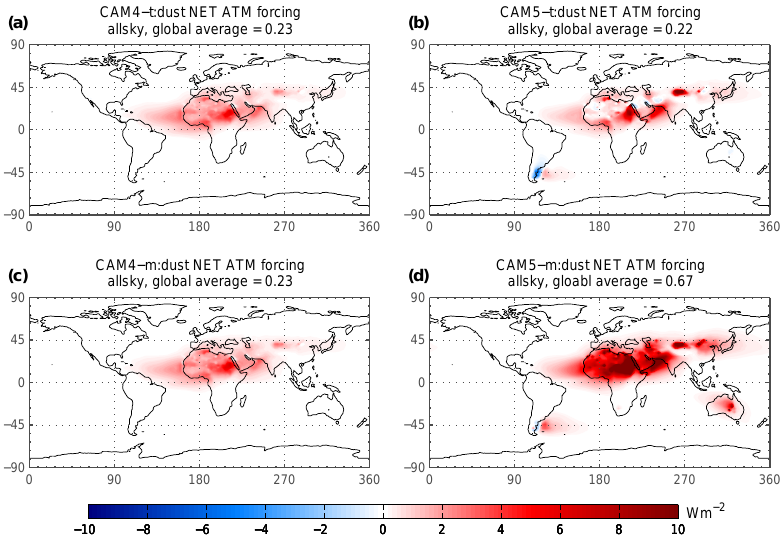
Figure 13. Spatial distribution of annual all-sky radiative forcing (SW + LW) in the atmosphere for CAM4 with tuned dust and with miner- alogy (a, c) and for CAM5 with tuned dust and mineralogy (b, d) .